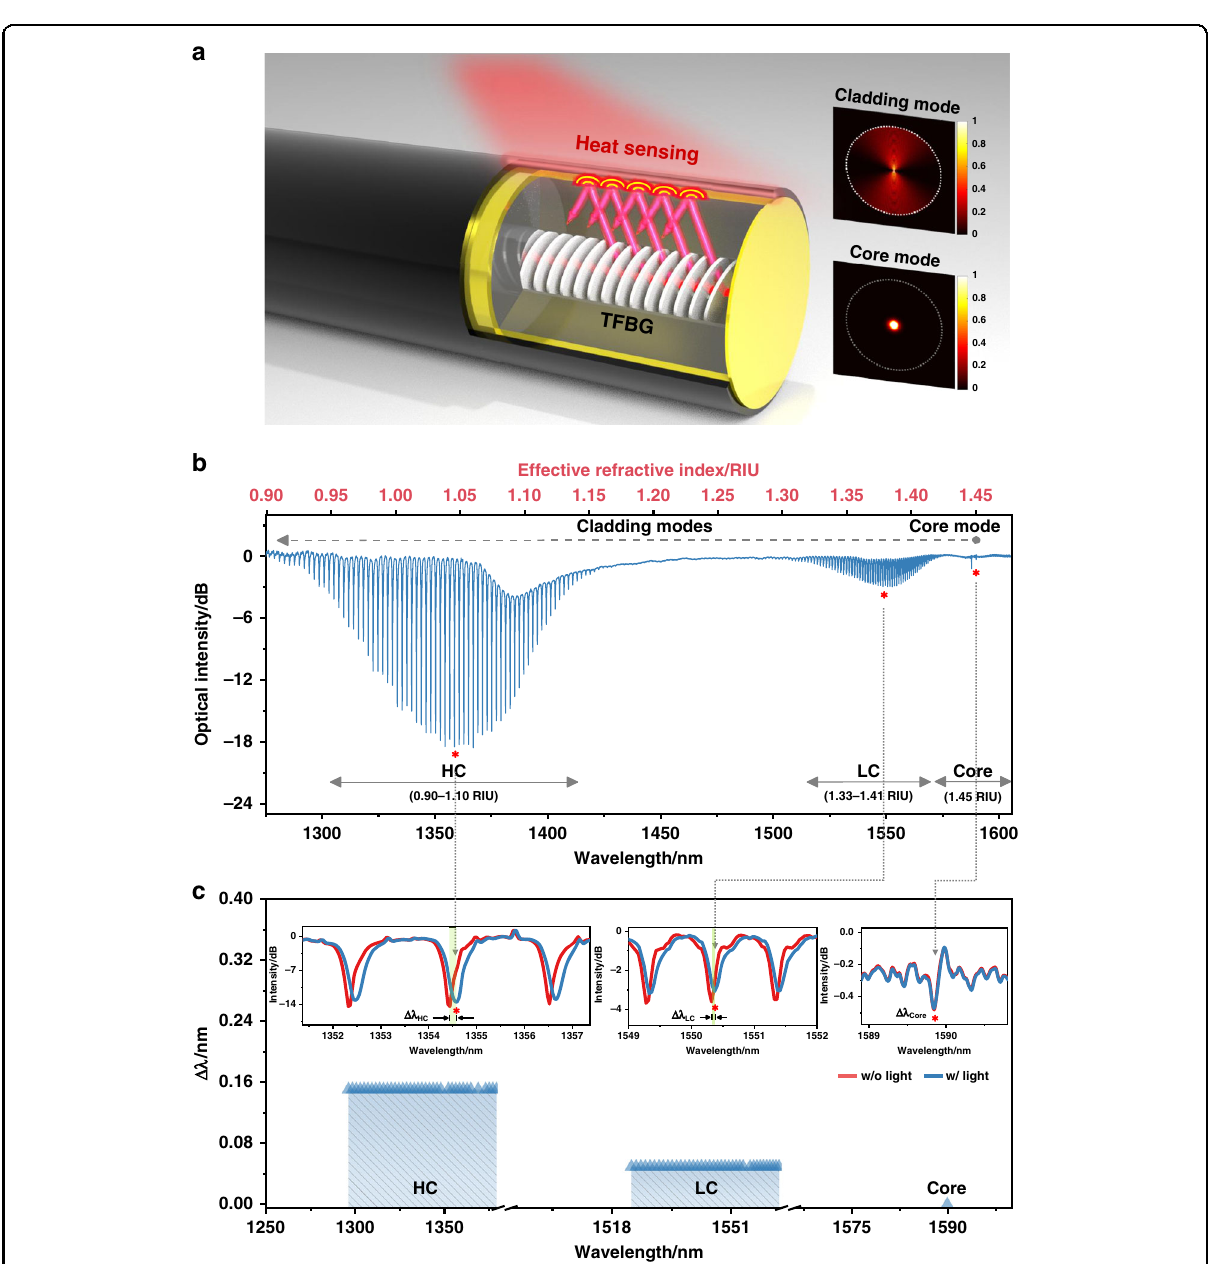
Fig. 3 Principle and demonstration of operando monitoring thermal effects via a gold-coated TFBG optical fi ber sensor. a Schematic illustration of a CNTs/Au-FOS with a TFBG in the fi ber core and an Au mirror (4 μ m) at the end of fi ber. The insets are the numerical simulation of guided mode fi eld intensity distributions for cladding mode and core mode. b Re fl ection spectrum of the fi ber sensor in water, and the corresponding wavelength of high-order cladding (HC) modes for HC (90 – 108) and low-order cladding (LC) mode for LC (39 – 61), and core. c Wavelength shifts ( Δ λ ) and corresponding spectral responses (the insets: HC (99), LC (49) and core) due to photo-induced catalytic processes over the Au fi lm. (Video S1 for HC mode response and Video S2 for core mode response are